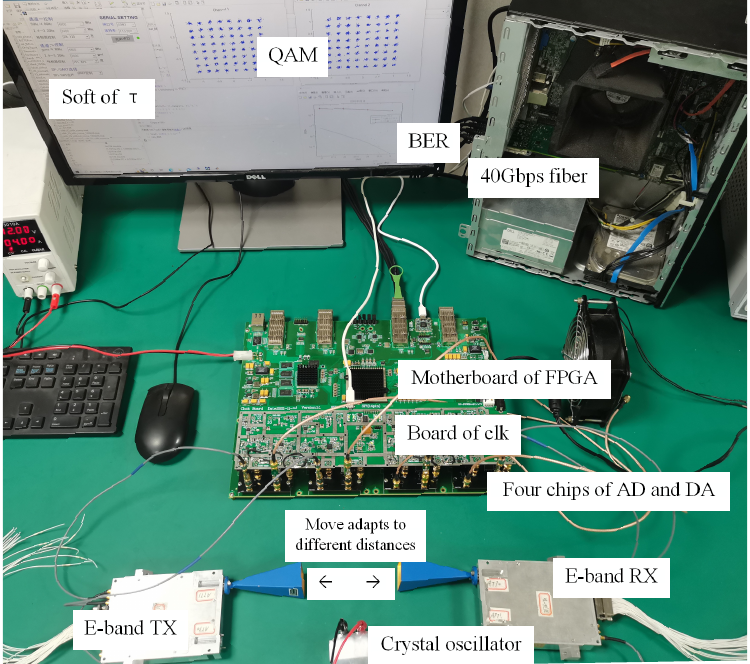
Figure 12. The test scene of simulating phase change by moving the antenna and adjusting the